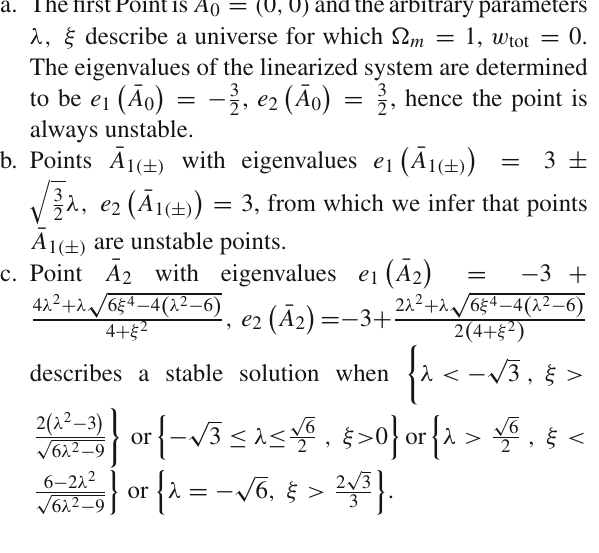
Fig. 5 Phase space portrait for in the variables { x ,λ } for the dynamical system (20), (21) and (24) and for U ( φ ) = U 0 φ n and Y (φ) = Y 0 φ 1 + 2 n without matter source. Left figure is for (cid:12) 2 n = − 0 . 1 and ξ = while 3 right figure is for n = − 0 . 1